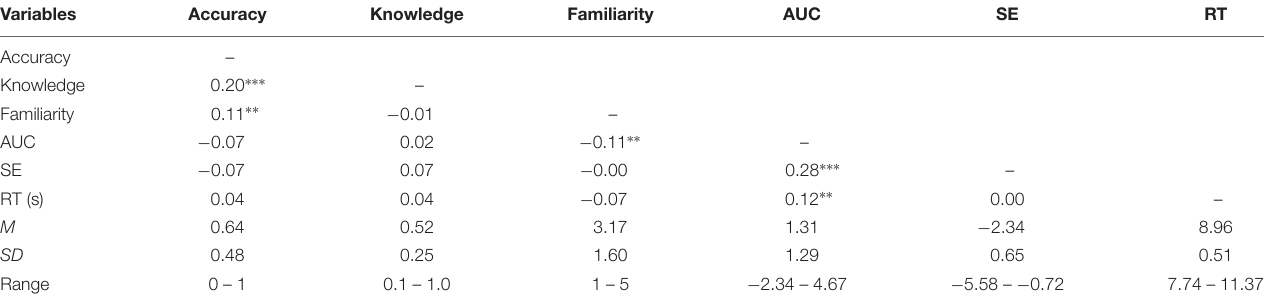
TABLE 1 | Correlation and descriptive statistics ( N = 736).